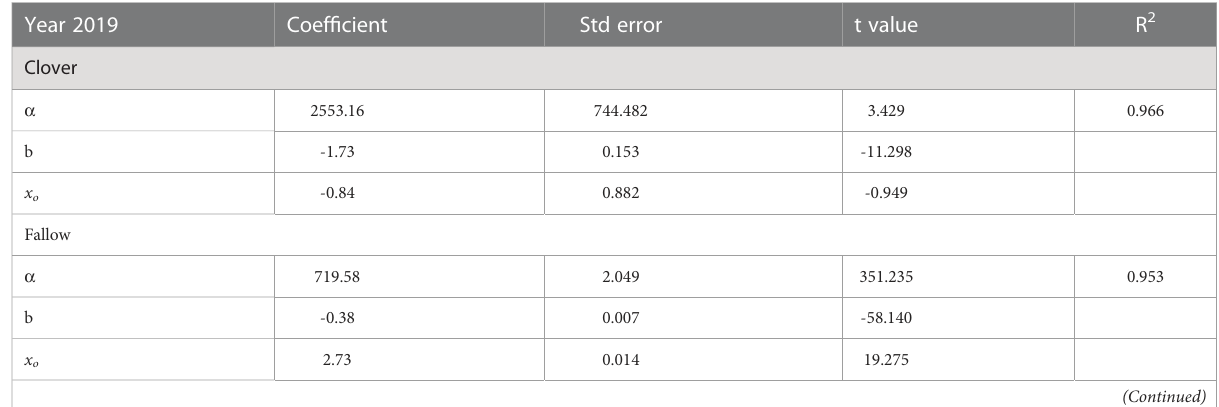
TABLE 5 Statistics for the three parameters logistic model used for fi tting weed biomass production under various weed-free periods for each of the conservation tillage following a crimson clover cover crop (CT + CC), conservation tillage following winter fallow (CT + WF), and conventional tillage without a cover crop (CVT) treatment in 2019 and